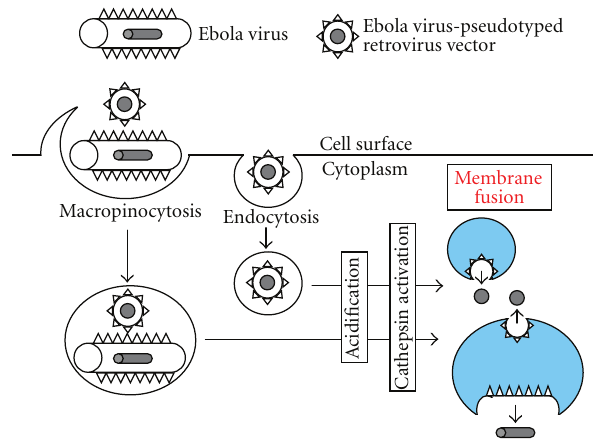
Figure 6: Entry pathways of Ebola virus and Ebola virus- pseudotyped retrovirus vector. Blue area indicates acidic condition.